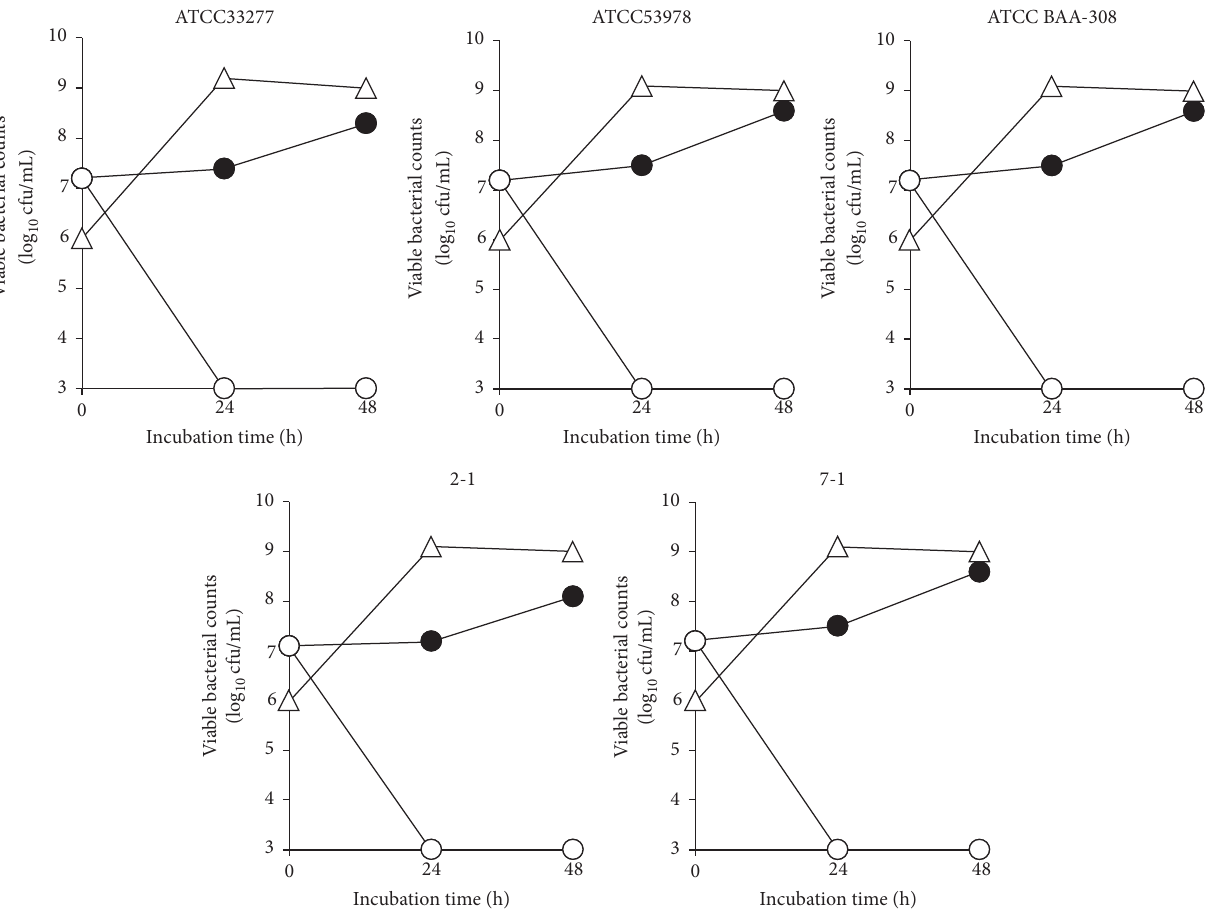
Figure 2: Viable counts of five strains of P. gingivalis (ATCC 33277, ATCC 53978, ATCC BAA-308, 2-1, and 7-1) and E. faecium WB2000 in mixed cultures. e : number of P. gingivalis in monoculture, I : number of P. gingivalis in mixed cultures with E. faecium WB2000, and △ : number of E. faecium WB2000 in mixed cultures with P. gingivalis